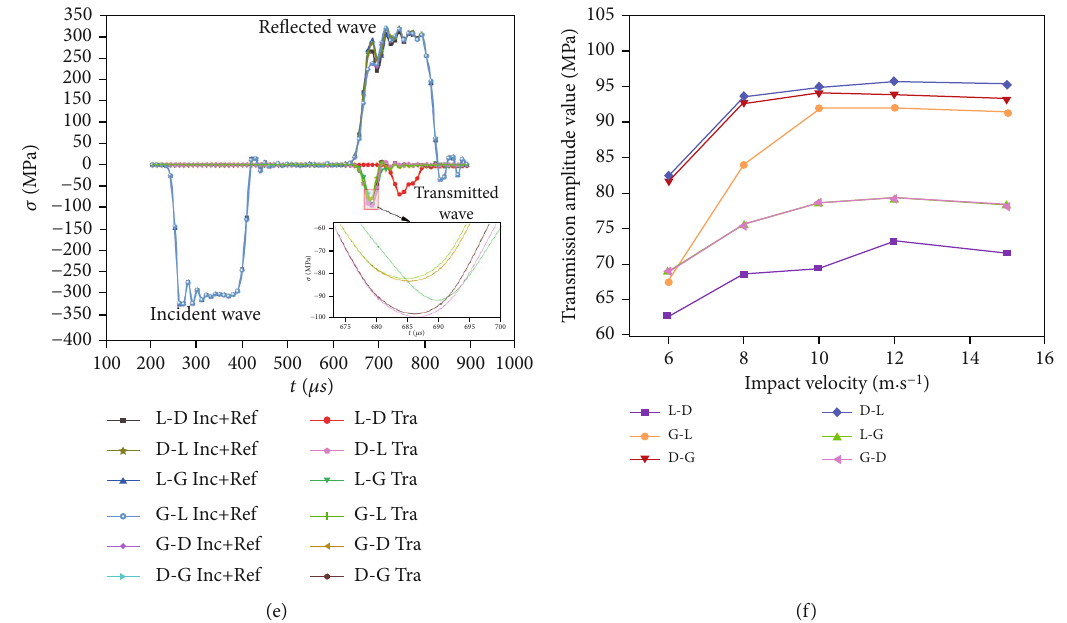
Figure 3: Waveform comparison of layered rock mass under di ff erent impact velocities: (a) 6 m/s; (b) 8m/s; (c) 10 m/s; (d) 12 m/s; (e) 15m/ s; (f) transmission amplitude